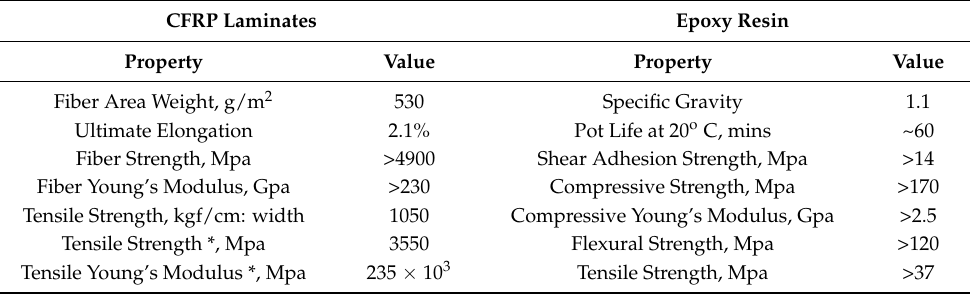
Table 2. The properties of the CFRP laminates and epoxy (from supplier data sheet). CFRP Laminates Property